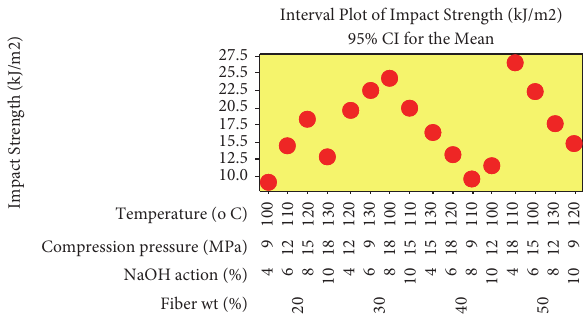
Figure 14: Interval plot used in impact strength analysis.